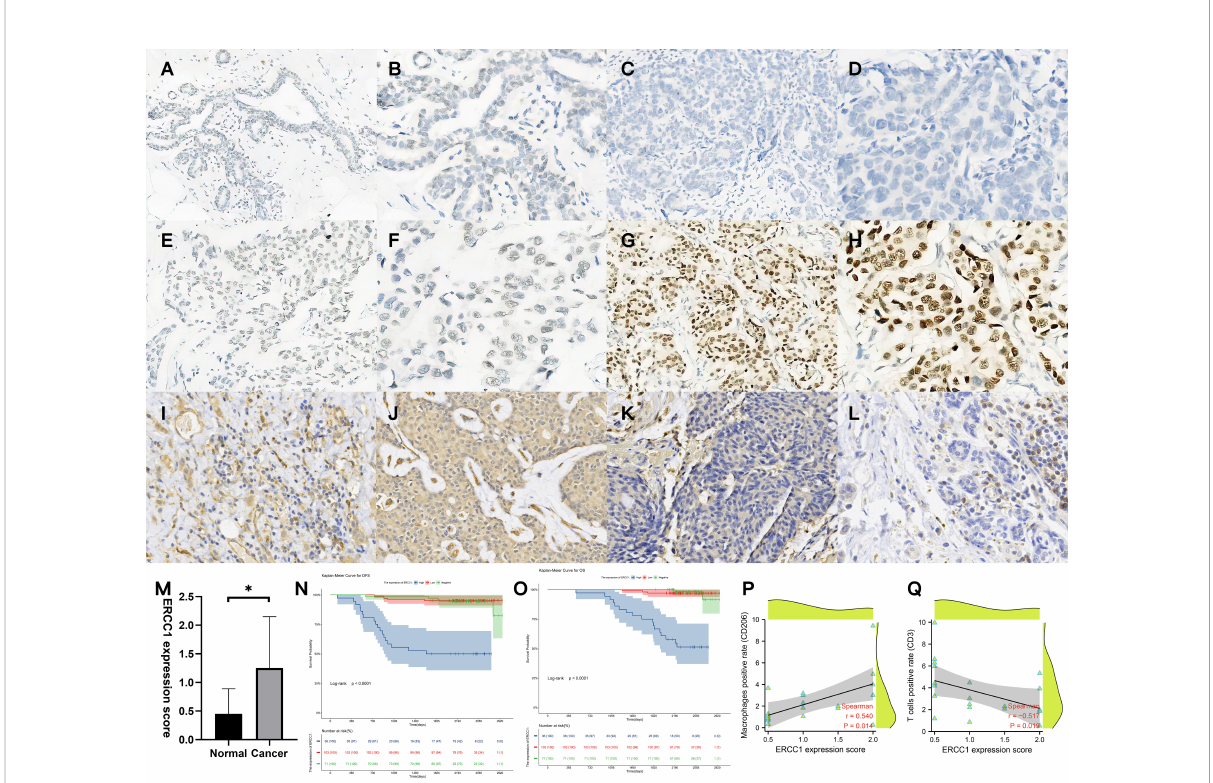
FIGURE 5 Validation of ERCC1 expression, survival analysis, and immune cell in fi ltration in patients. (A, B) Immunohistochemical (IHC) staining of ERCC1 in normal tissues, (A) Magni fi cation, 10×10, (B) Magni fi cation, 20×10. (C, D) IHC staining of ERCC1 in HER2 over-expressing breast cancer tissues (Expression: negative). (C) Magni fi cation, 10×10, (D) Magni fi cation, 20×10. (E, F) IHC staining of ERCC1 in HER2 over-expressing breast cancer tissues (Expression: low level). (E) Magni fi cation, 10×10, (F) Magni fi cation, 20×10. (G, H) IHC staining of ERCC1 in HER2 over-expressing breast cancer tissues (Expression: high level). (G) Magni fi cation, 10×10, (H) Magni fi cation, 20×10. (I, J) IHC localization of CD206 indicates macrophage in fi ltration in 20 patients with different levels of ERCC1 expression. (I) ERCC1 expression level: low, magni fi cation, 20×10. (J) ERCC1 expression level: high, magni fi cation, 20×10. (K, L) IHC localization of CD3 indicates T cell in fi ltration in 20 patients with different levels of ERCC1 expression. (K) ERCC1 expression level: low, magni fi cation, 20×10. (L) ERCC1 expression level: high, magni fi cation, 20×10. (M) Expression of ERCC1 in normal and cancer tissue. (N) Survival analysis grouped by ERCC1 expression (DFS), (O) Survival analysis grouped by ERCC1 expression (OS) Blue: high level, Red: low level, Green: negative. (P) Spearman ’ s rank correlation analysis determined the correlation between ERCC1 expression score and positive cell percentage of T cells (CD3). (Q) Spearman ’ s rank correlation analysis determined the correlation between ERCC1 expression score and positive cell percentage of macrophages (CD206). *P <